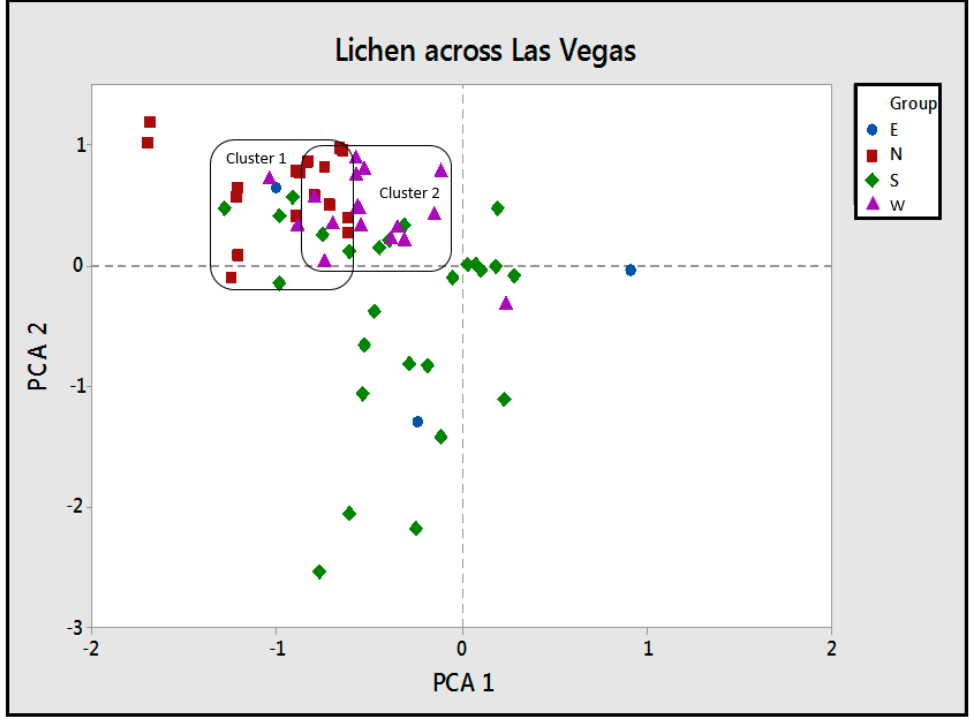
Figure 3. Principal component analysis showing two clusters across the Las Vegas Valley.